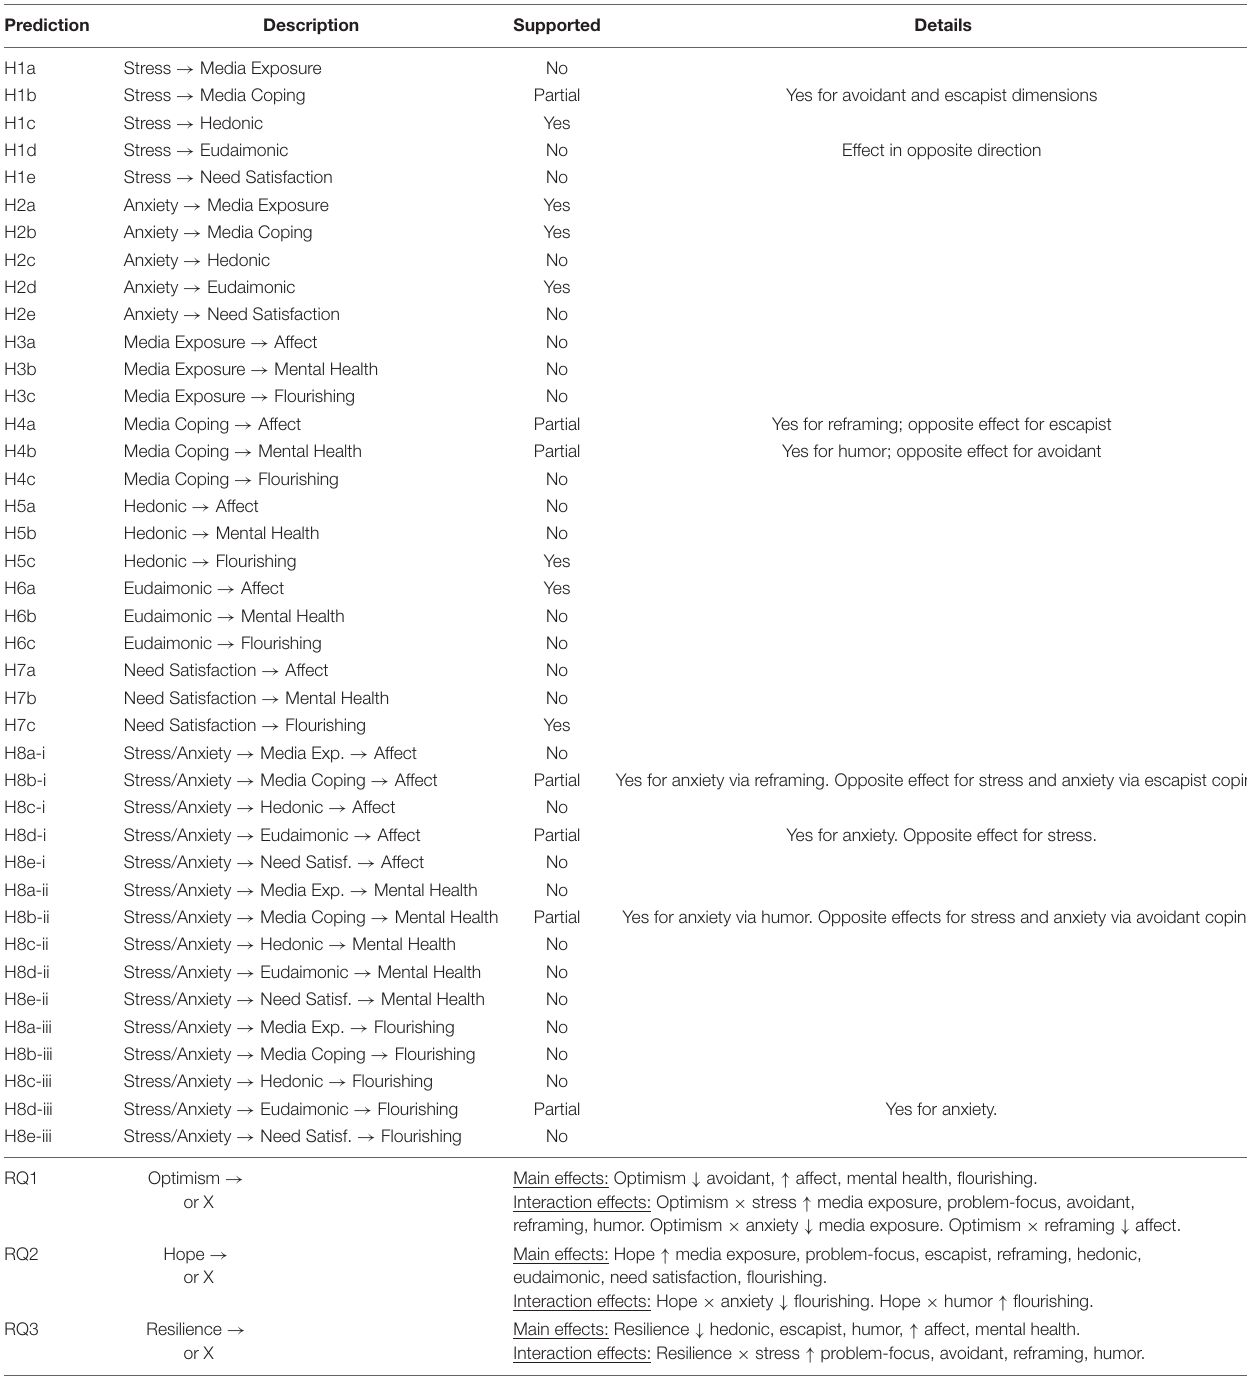
TABLE 7 | Summary of hypothesis testing. Prediction